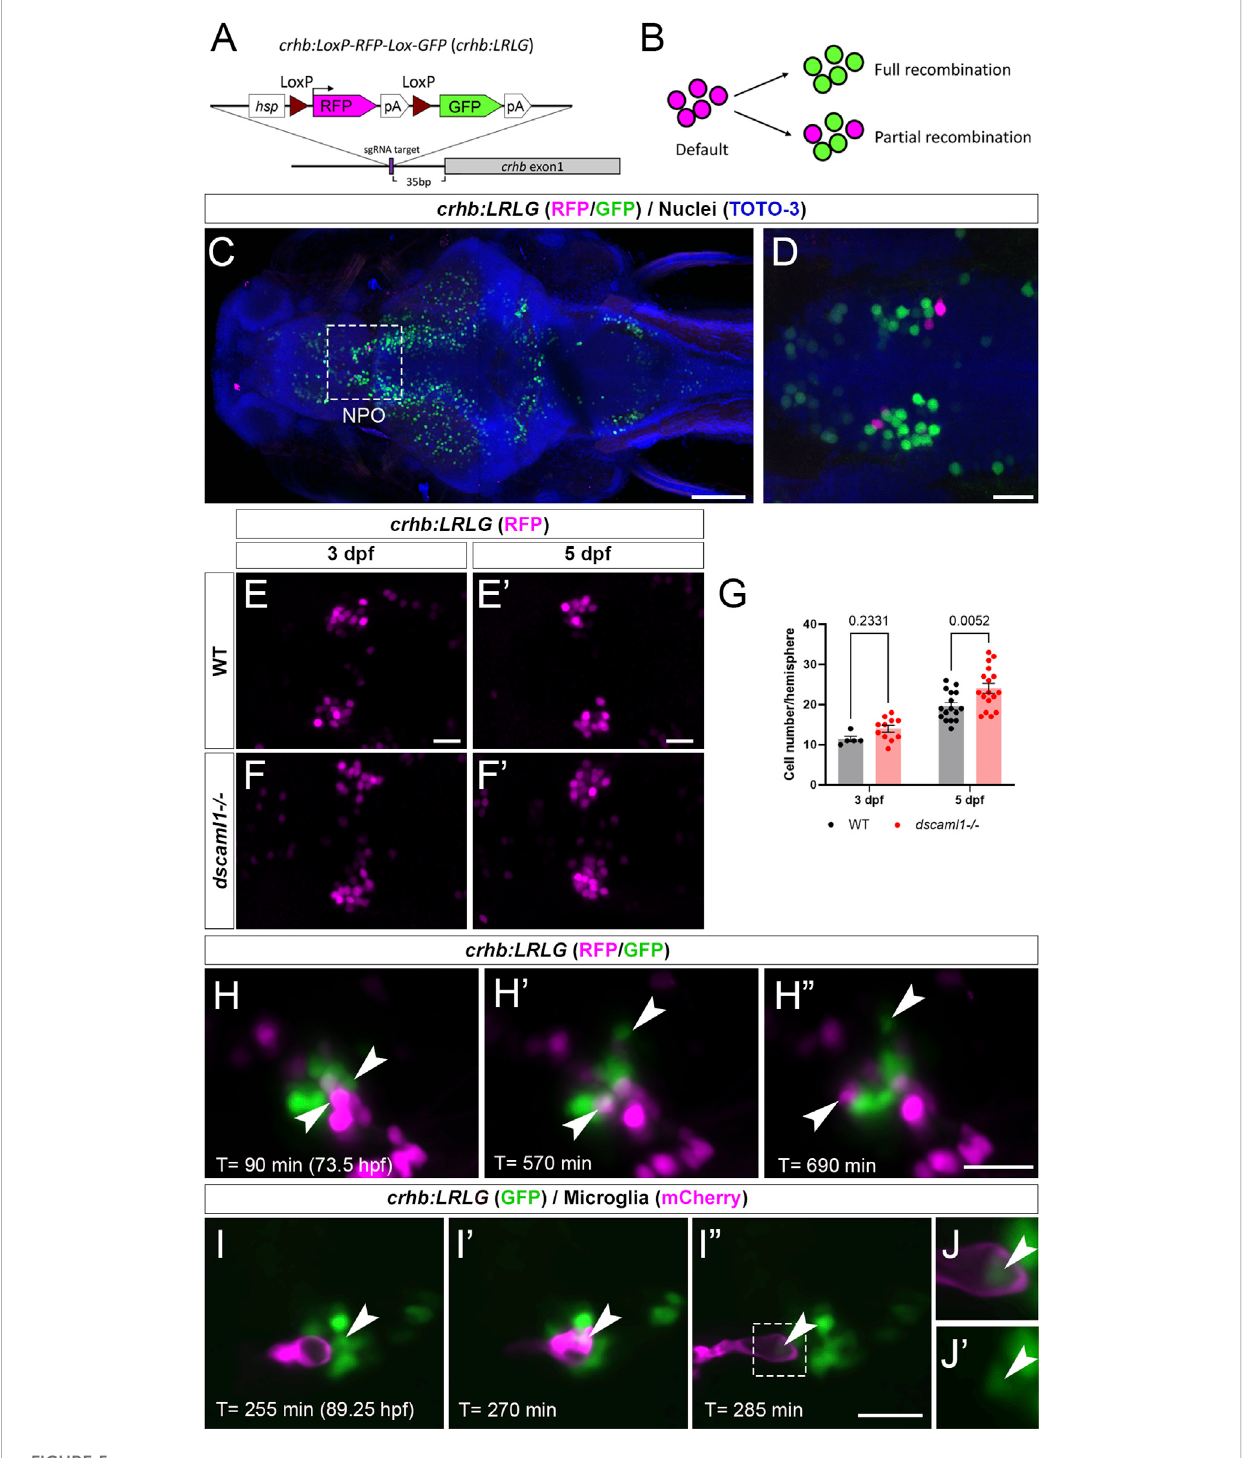
FIGURE 5 FluorescentlabelingandliveimagingofCRH NPO neurons. (A) SchematicofCRISPR-mediatedknock-inofthe hsp-Lox-RFP-Lox-GFP cassetteatthesgRNA targetsite,located35bpupstreamofexon1of crhb .Theorientationandjunctionalstructureofinsertionhavenotbeendetermined. (B) Schematicof crhb:LRLG expression. Each circle represents a fl uorescent cell. Without Cre (default), RFP is expressed in all cells. With full recombination, all cells express GFP. Partial recombination results in mosaic RFP and GFP labeling. (C) Dorsal view of a fi xed 5 dpf crhb:LRLG larvae with partial recombination stained with anti-RFP (magenta) and anti-GFP (green). The boxed area marks the NPO. (D) Higher magni fi cation image of the NPO. Both RFP and GFP-positive neurons can be seen. (E-F ’ ) Images of anti-RFP stained crh:LRLG animals without recombination. Representative WT (E-E ’ ) and dscaml1 − / − (F-F ’ ) NPO neurons are shown. (G) Quanti fi cationofRFP-positivecellsat3and5dpf.WT:n=5(3dpf),16(5dpf). dscaml1 − / − :n=11(3dpf),17(5dpf).Mean,standarderror,andcorrected p valuesare shown. (H – H ” ) Live crhb:LRLG larvaewithpartial recombination were imagedfrom 72 to 84 hpf. Threetime pointsareshown here. Two cells (arrowheads, one green and one magenta) move away over time. (I – I ” ) Live crhb:LRLG;mpeg1:Gal4;UAS:NTR-mCherry larvae with CRH neurons labeled with GFP (green) and